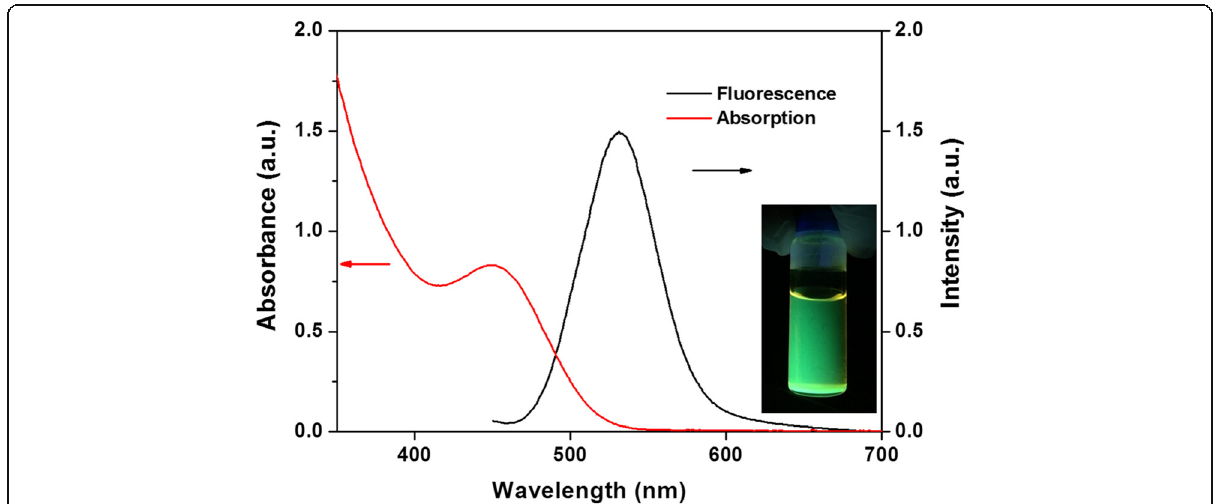
Fig. 3 UV-Vis spectra (red line) and fluorescence spectra (black line) of InP/ZnS core/shell QDs. The inset showed the green fluorescence of InP/ZnS core/shell QDs irradiated by hand-held long-wave UV lamp